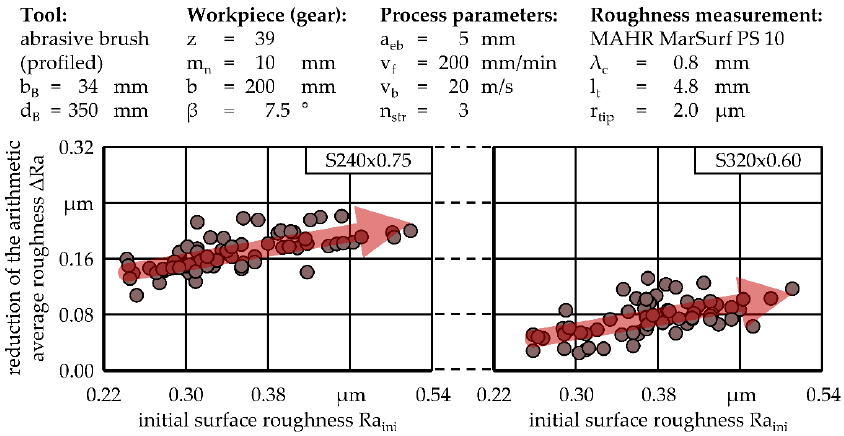
Figure 12. Correlation of the reduction in the arithmetic average roughness Δ Ra and the initial surface roughness Ra ini .